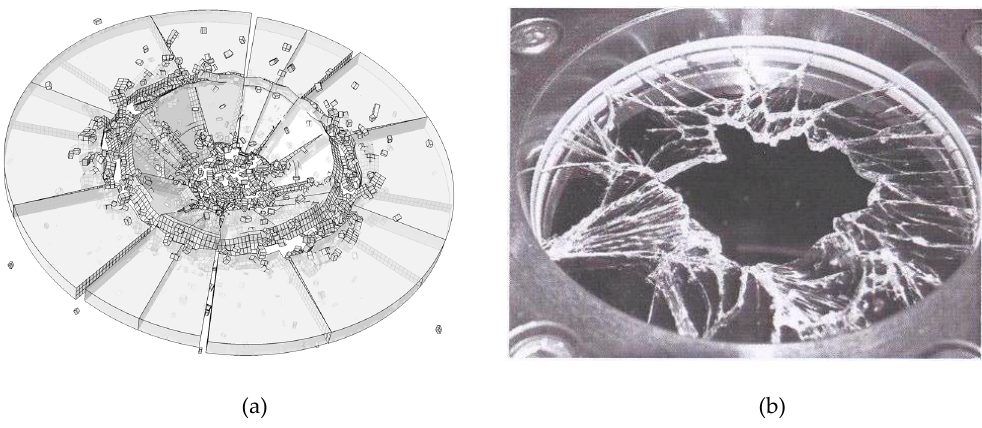
Figure 7. Comparison of the numerical test result and laboratory test result. ( a ) Numerical result; ( b ) experimental result [46].